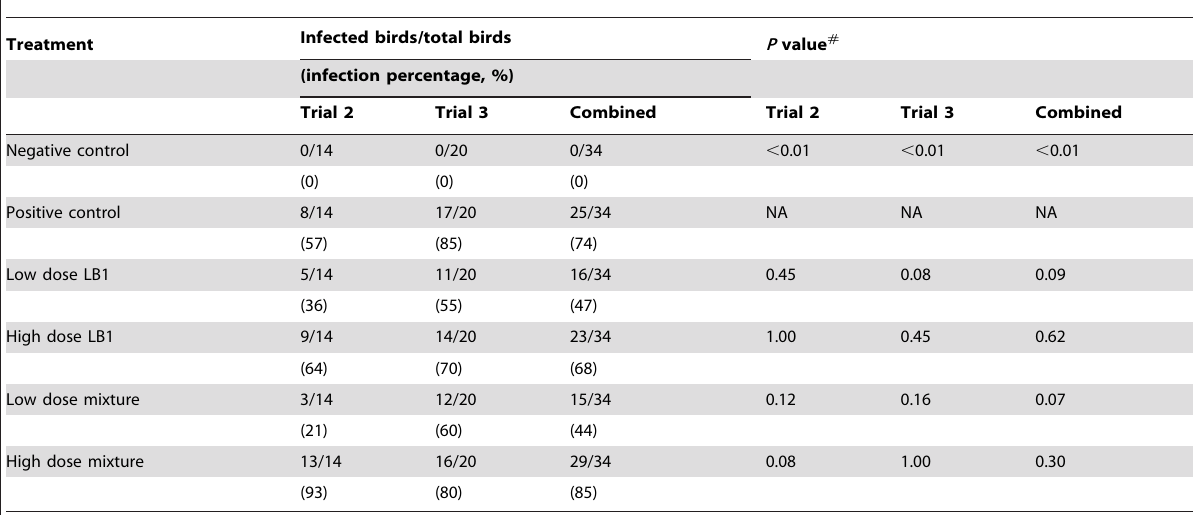
Table 6. Salmonella invasion to the liver on days 3 and 4 post-infection * .